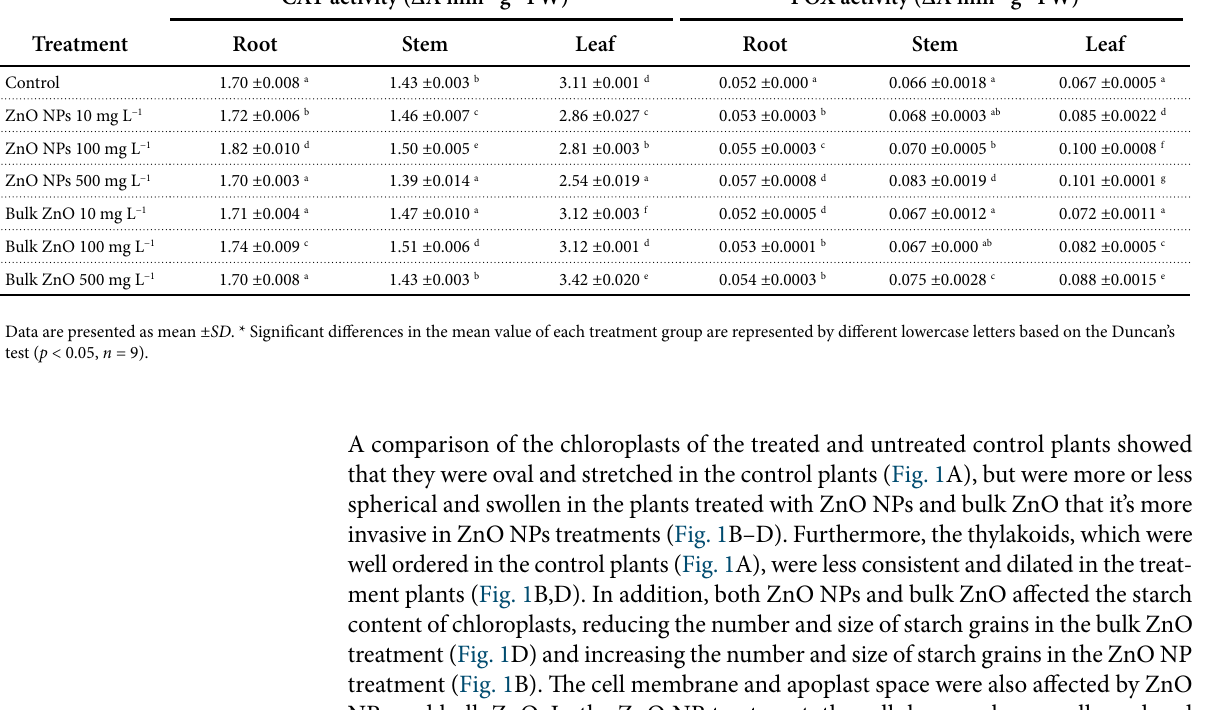
Tab. 3 Effects of ZnO NP and bulk ZnO treatments on antioxidant enzymes in Portulaca oleracea L.